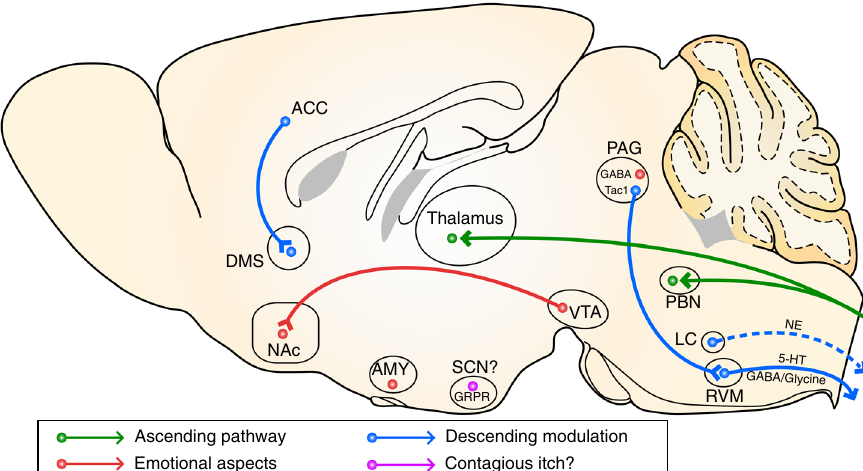
Fig. 2 Brain circuits for itch signal processing and modulation. The chemical itch signals are fi rst relayed to the PBN and thalamus by spinal projection neurons, while visually contagious itch in mice is proposed to be mediated by the SCN GRPR + neurons in the hypothalamus. The emotional components of itch sensation may be encoded by the amygdala, GABAergic neurons in the PAG, and different neuronal populations in the VTA. The PAG Tac1 -RVM circuit is involved in the descending modulation of itch signal processing, and brain-derived neuromodulators such as 5-HT and noradrenaline can also substantially modulate spinal itch circuits in a feedback manner. Projections from the ACC to the DMS selectively modulate histamine-dependent itch. AMY amygdala, LC locus coeruleus, NE